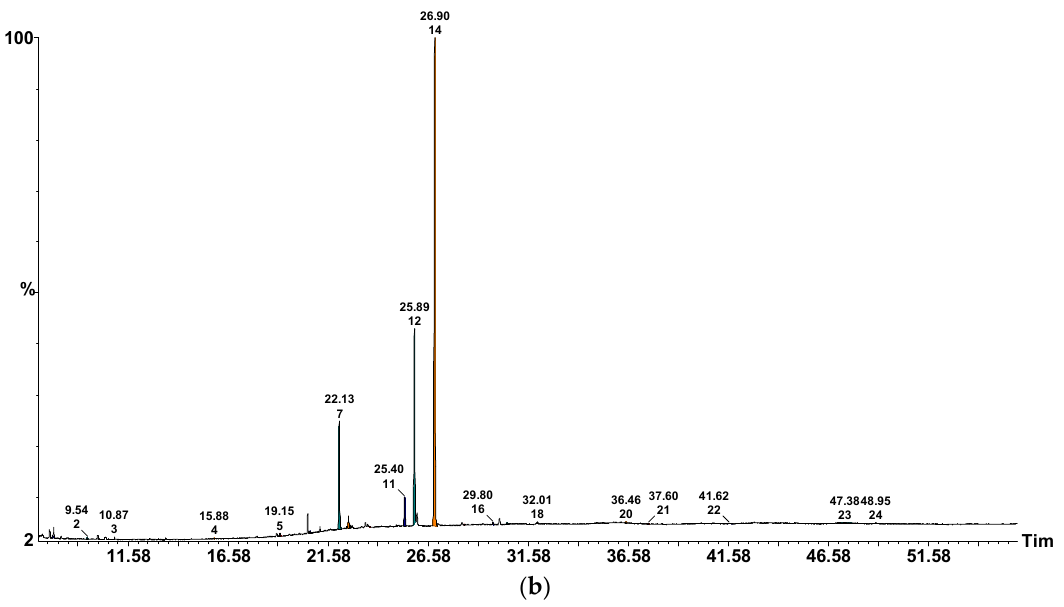
Figure 1. GC-MS chromatogram and retention time of fatty acids methyl esters (FAMEs) in the TLs of dried mushroom sample: ( a ) A. bisporus ; ( b ) B. edulis . The numbering of the peaks refers to Table 2.